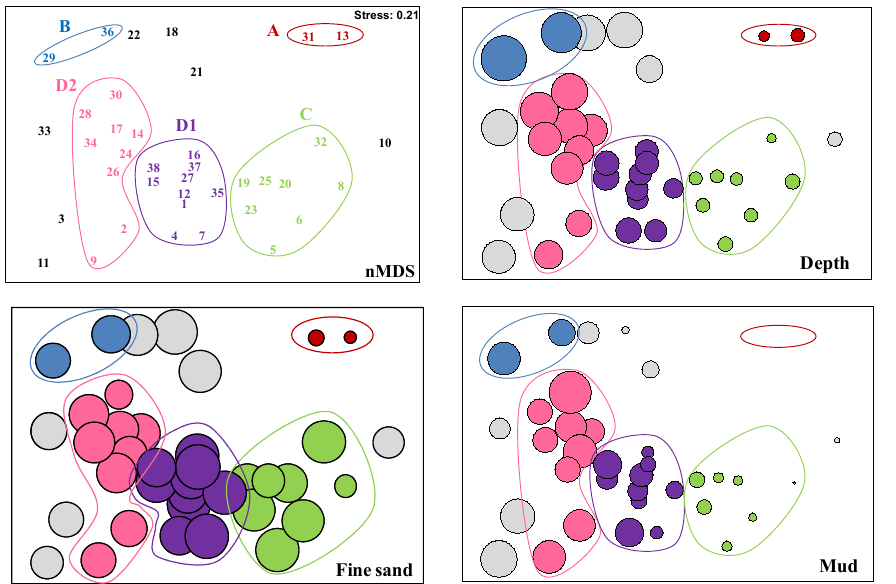
Figure 4. Location of sampling sites in the ACS showing the groups determined by cluster analysis.